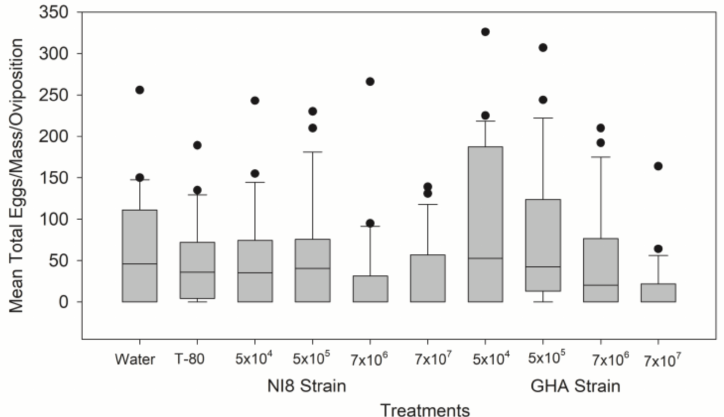
Figure 3. Mean total eggs/oviposition of Nezara viridula treated with 2 strains of Beauveria bassiana NI8 and GHA at different concentrations (one-way ANOVA and Tukey’s HSD test p = 00.5; means